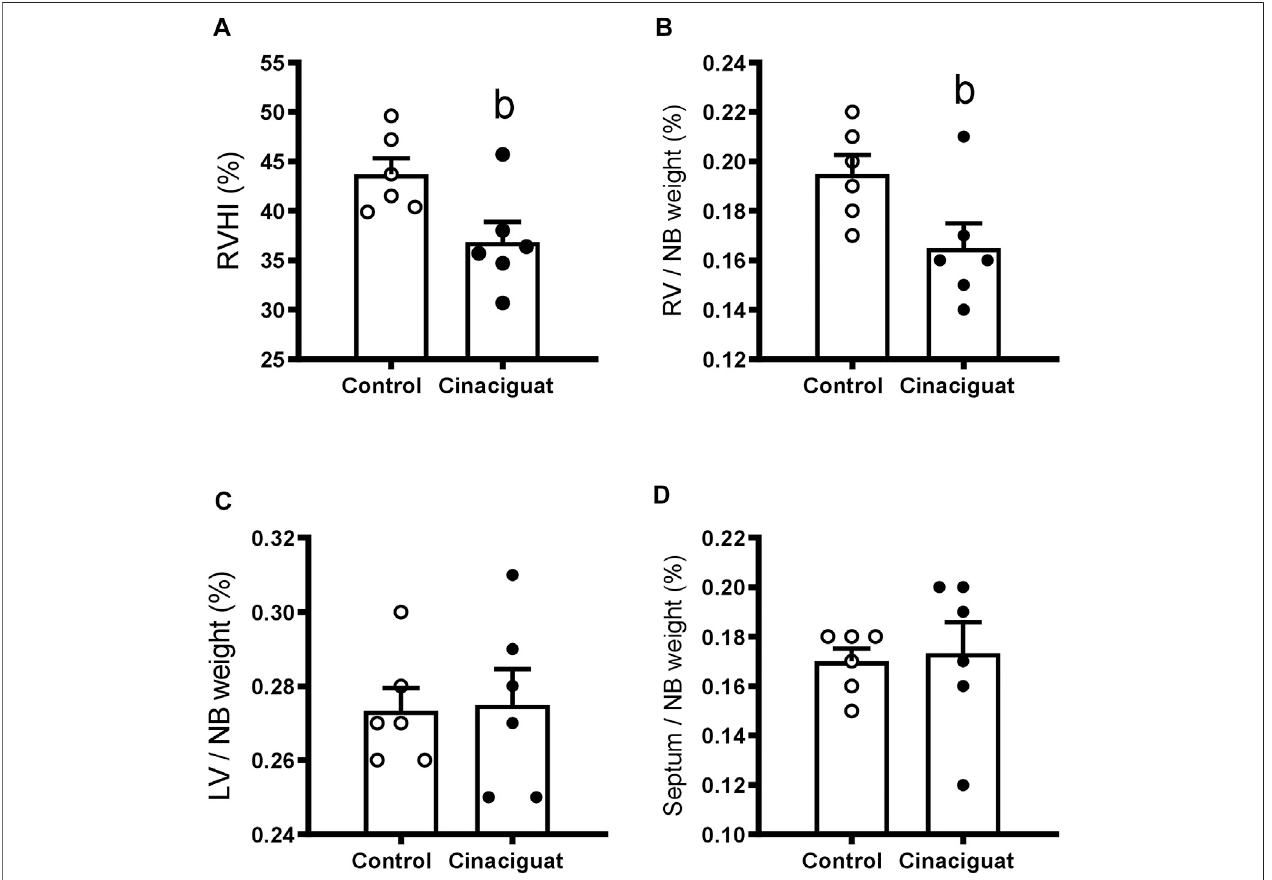
FIGURE 4 | Effect of Cinaciguat treatment on heart ventricles of chronically hypoxic and pulmonary hypertensive neonatal lambs. Percentages of right ventricular hypertrophyindex[(rightventricle/(leftventricle+septum)×100] (A) ;[(rightventricleweight/newbornweight)x100] (B) ;[(leftventricleweight/newbornweight)x100] (C) , and [(septum weight/newborn weight) ×100] (D) . Control (Open circles, n = 6) and Cinaciguat-treated lambs (Black circles, n = 6). Values are means ± SEM. Signi fi cant difference ( p ≤ 0.05): b vs. Control group.